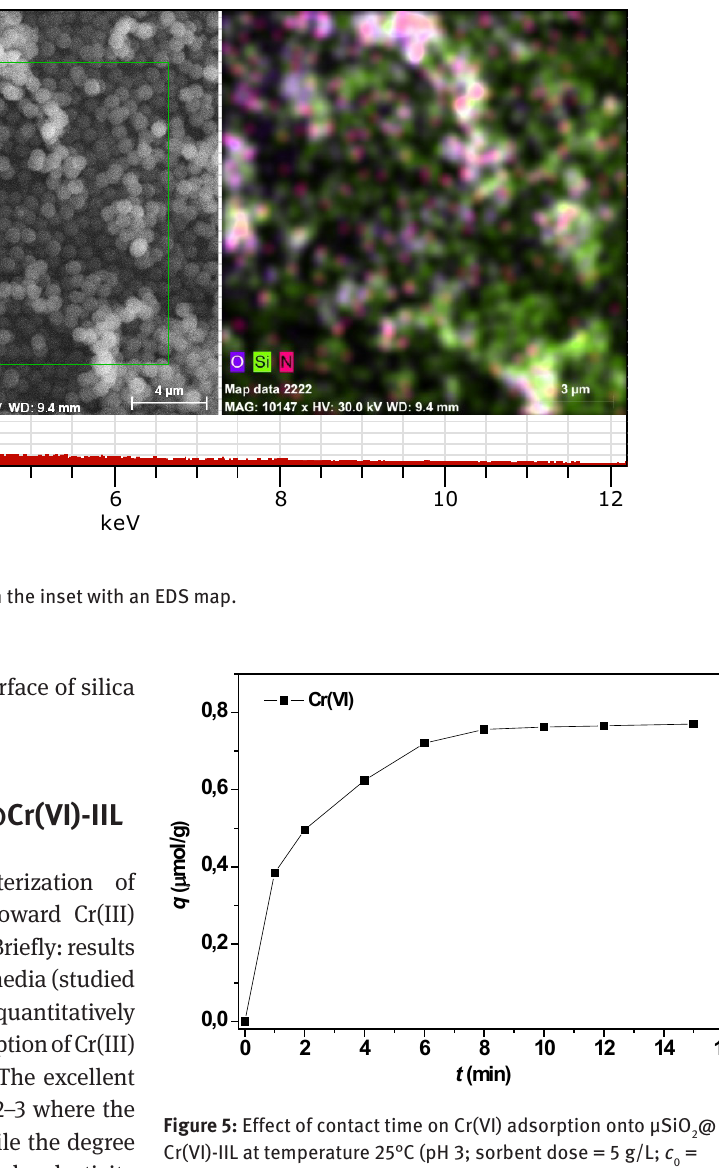
Figure 5: Effect of contact time on Cr(VI) adsorption onto µSiO Cr(VI)-IIL at temperature 25°C (pH 3; sorbent dose = 5 g/L; c 3,846